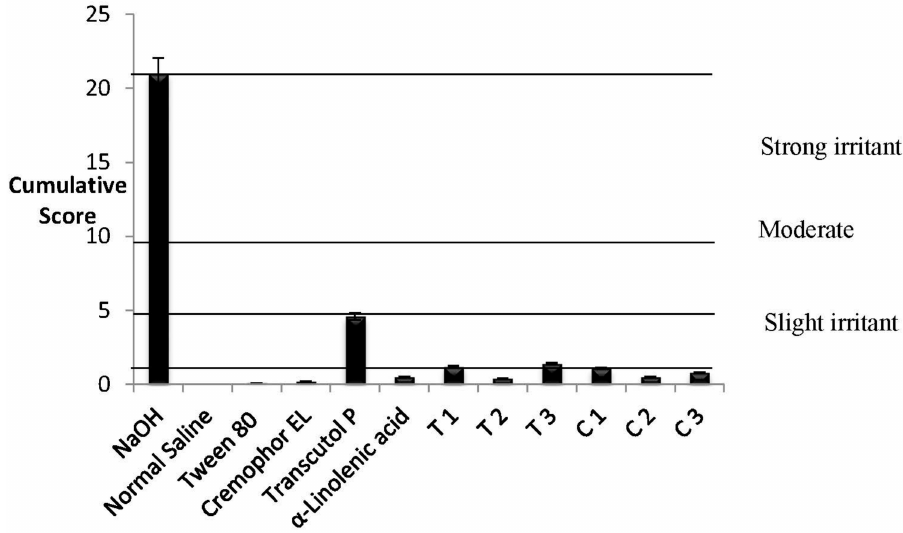
Figure 9. Cumulative HET-CAM scores of NaOH, Acetone, Normal Saline, Tween 80, Cremophor EL, Transcutol P, and the microemulsion formulations; T1, T2, T3 and C1, C2 and C3. Results are expressed as mean values ± SD, n =